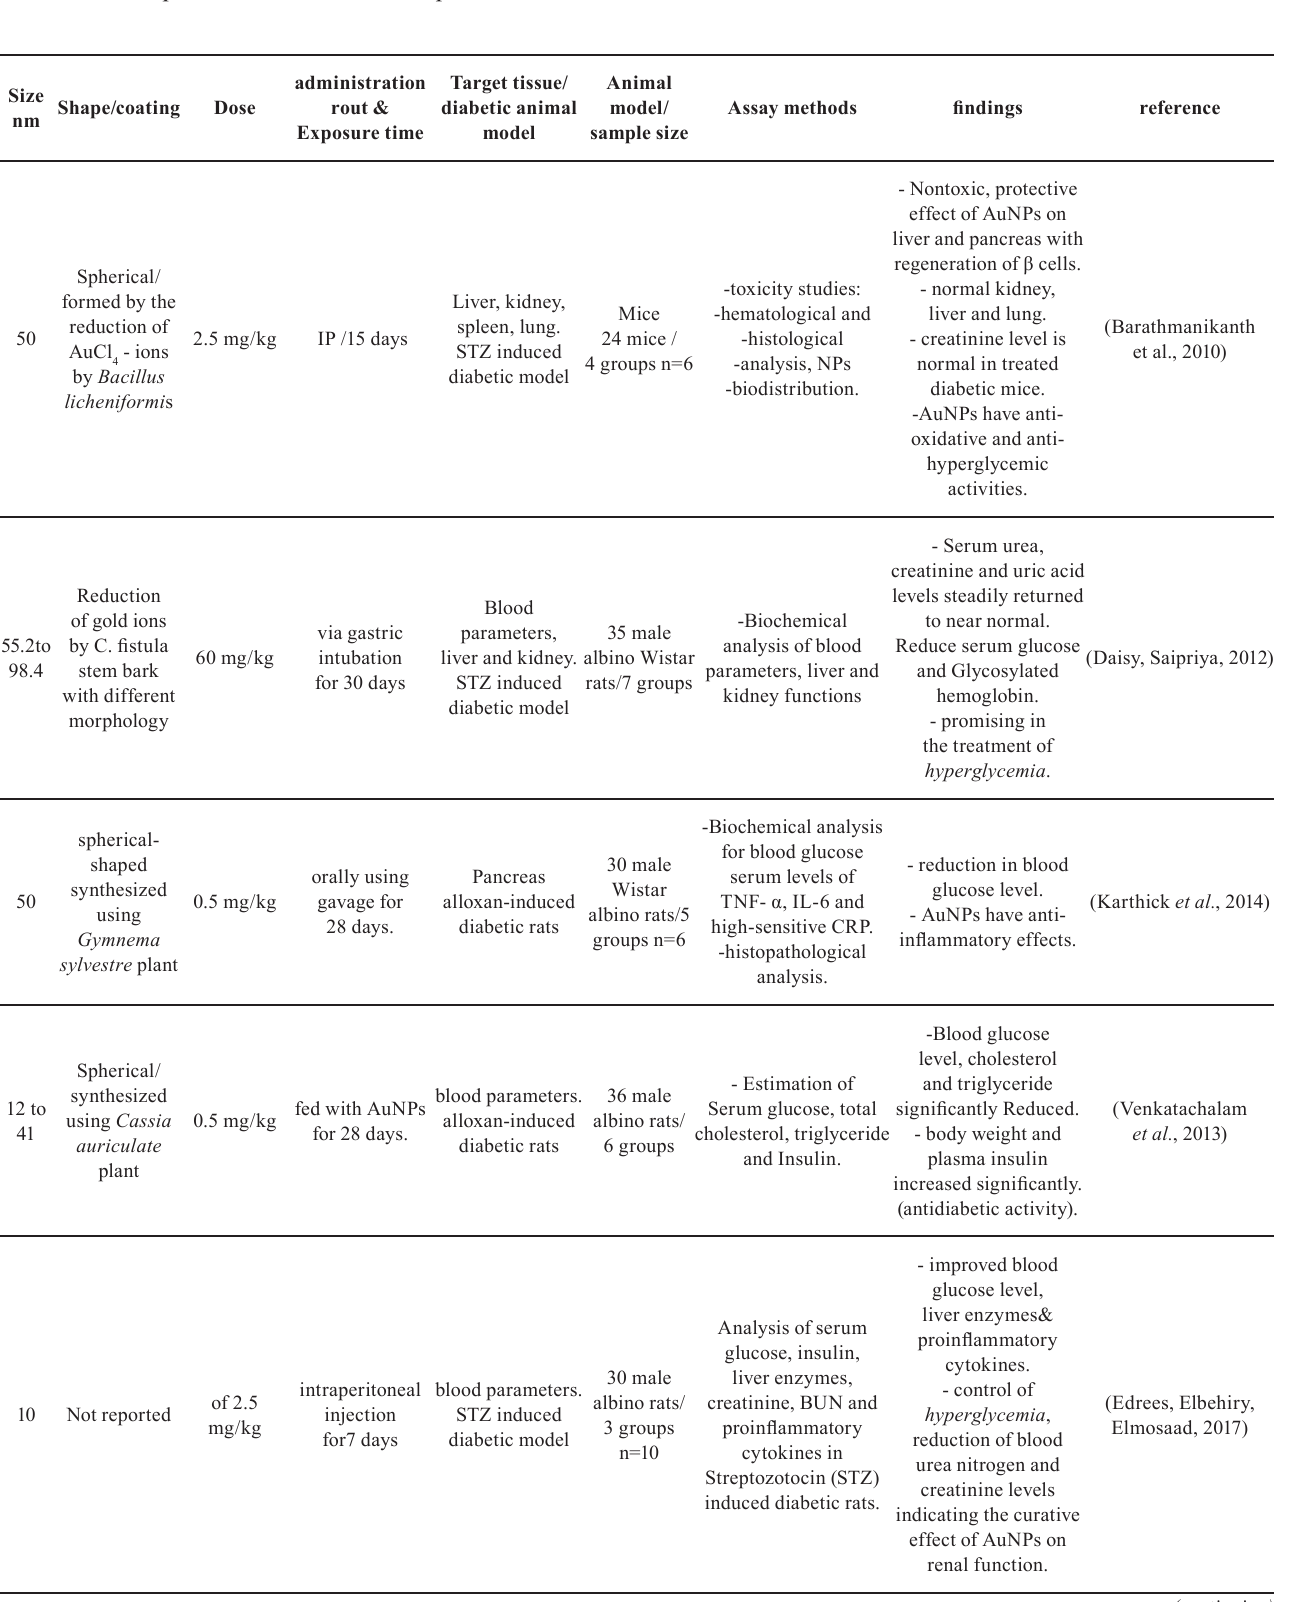
TABLE I – Therapeutic effects of Gold nanoparticles on diabetic animal